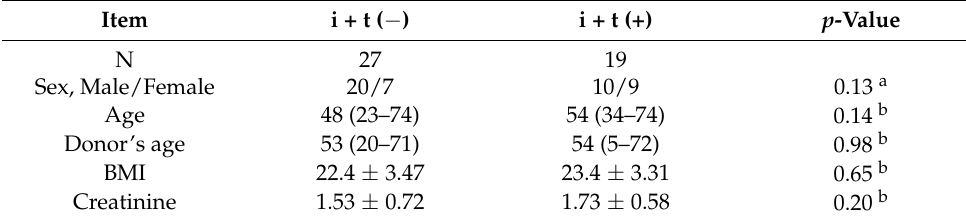
Table A1. Characteristics of participants with i + t (+) and i + t ( − ).